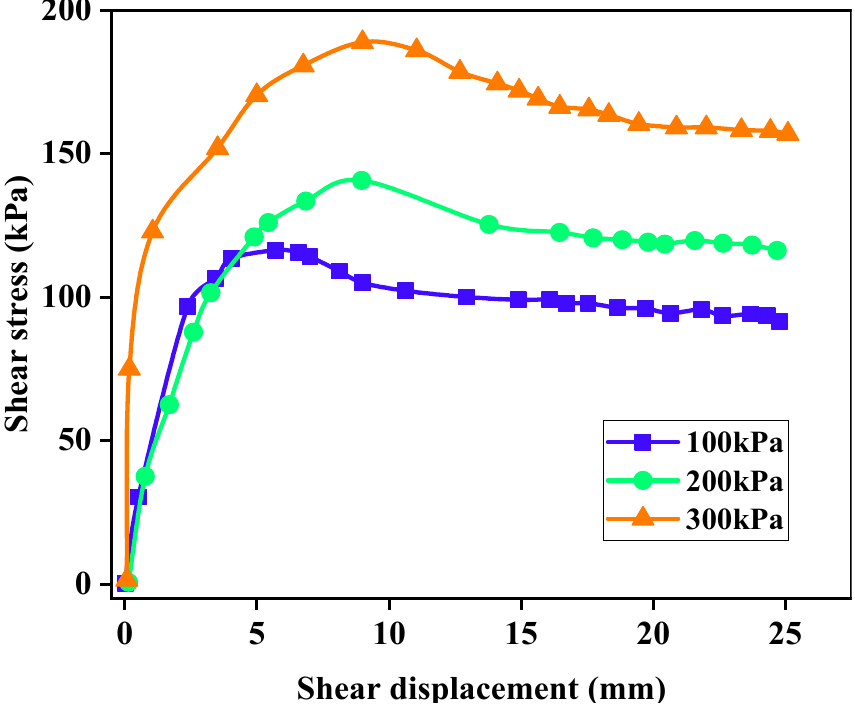
Figure 8. Shear stress-displacement curves of different normal stresses when the CAR was 4:6.